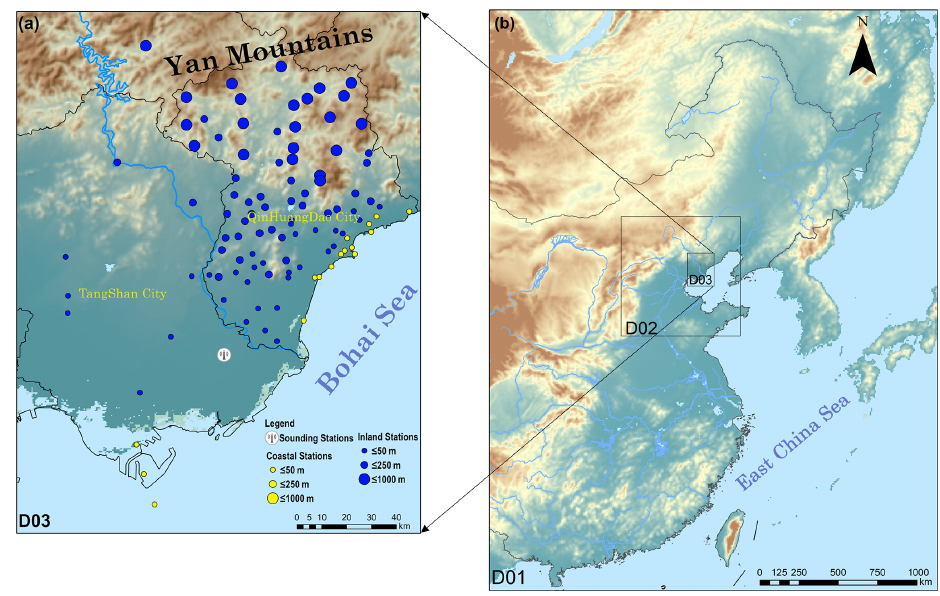
Figure 1. Map showing the (a) study area and (b) WRF nested domains (D01–D03). Solid yellow and blue circles in panel (a) represent coastal (16 stations in total) and inland stations (89 stations in total), the sizes of the circles represent the station elevations, and the white circle represents the sounding station.